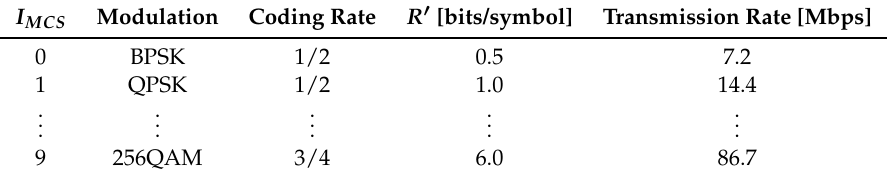
Table 3. Relationship between MCS index and transmission rate under IEEE802.11ac at 20